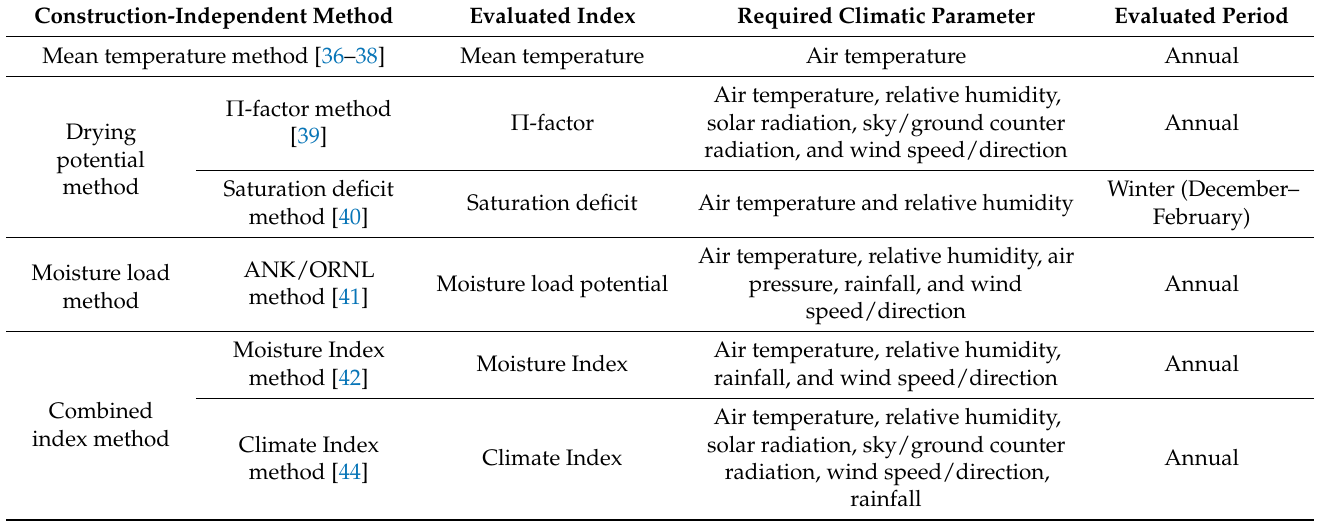
Table 1. Summary of construction-independent